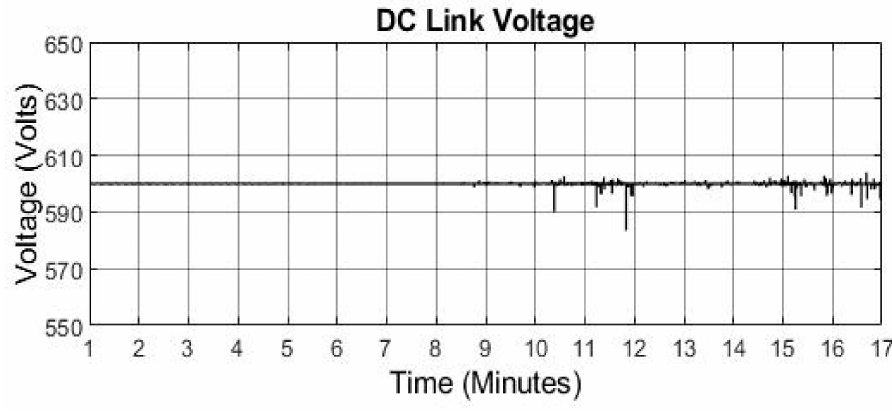
Figure 16. DC link voltage profile for load model 2.